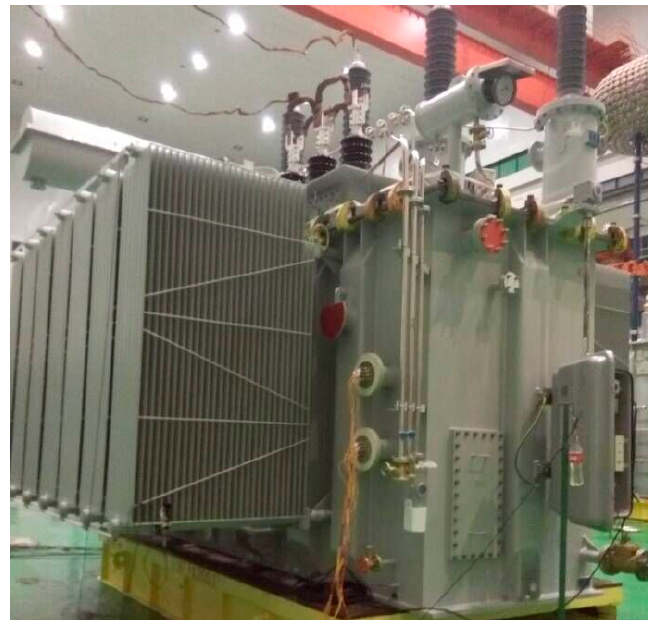
Figure 2. 110 kV three-phase three-limb transformer.